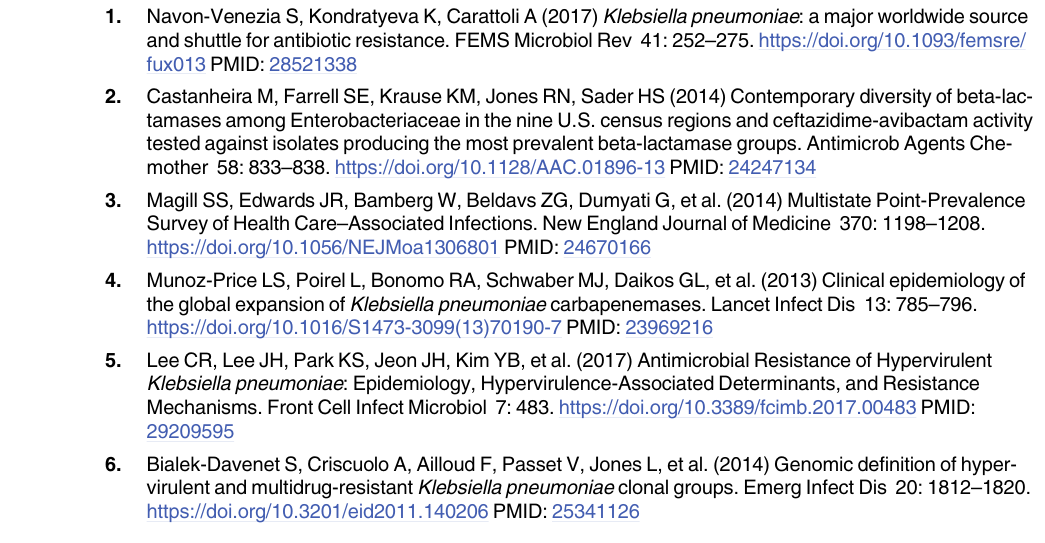
S3 Data. Summary of individual amino acid and protein concentrations from Lcn2 +/+ and Lcn2 -/- BALF. S1 Table. Primers used in this